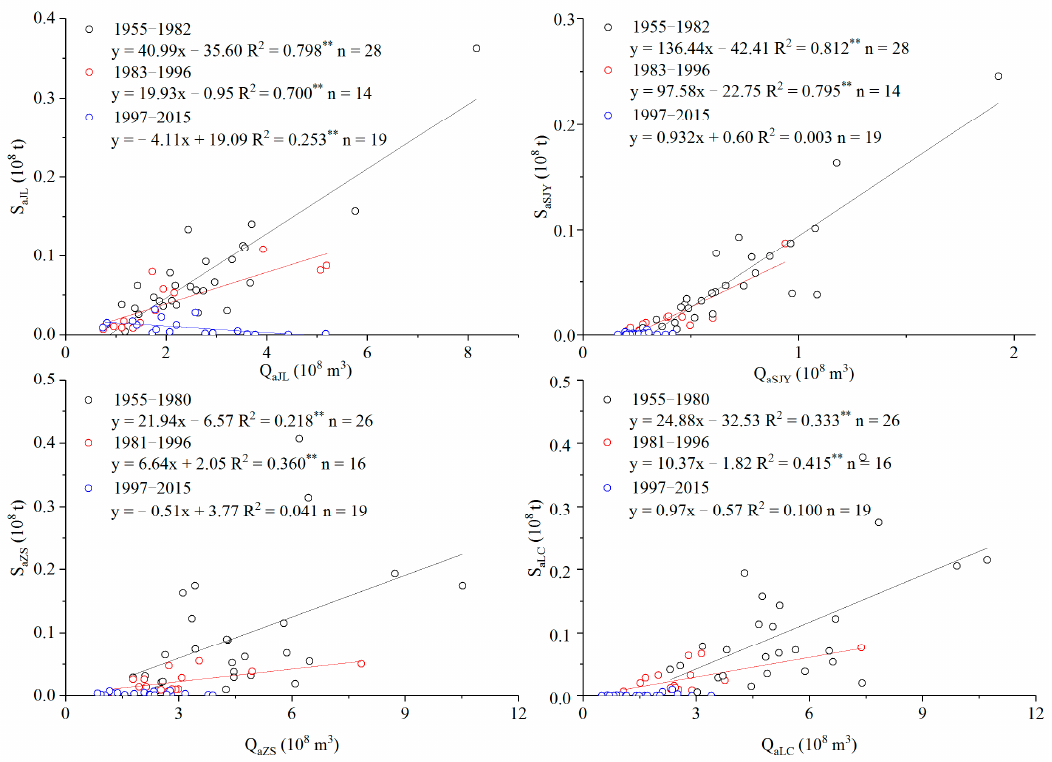
Figure 5. Scatterplot distributions and regression equations for the Q a –S a relationships for the four stations. ** Significant at p < 0.01.